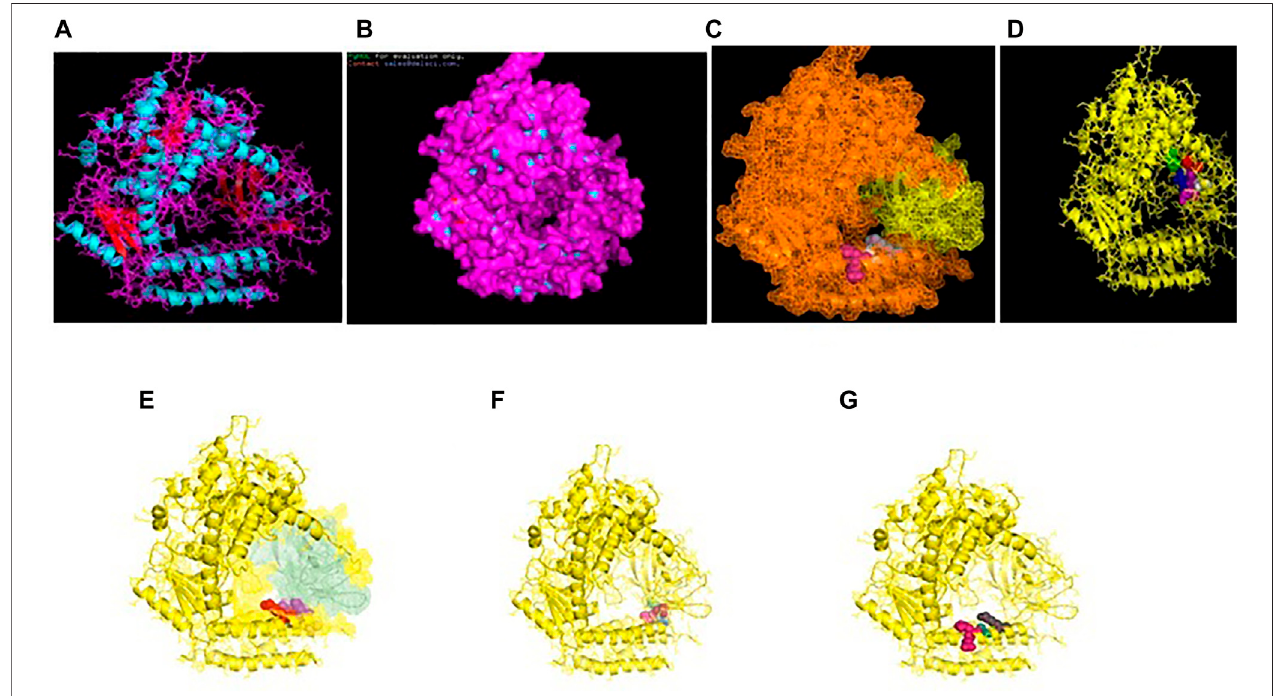
FIGURE2| (A) 3D structure of RIG1ofduck. (B) 3D structure ofRIG1ofduck, surface view. (C) 3D structure of RIG1ofduck withsites for helicase insertdomain, helicasedomaininterface(polypeptidebinding). (D) 3DstructureofRIG1ofduckdepictingdsRNAbindingsite. (E) 3DstructureofRIGIofduckwithRDinterfaceandRIG IC. (F) 3D structure of RIG1 of duck for zinc binding site. (G) 3D structure of RIG1 of duck of RNA binding